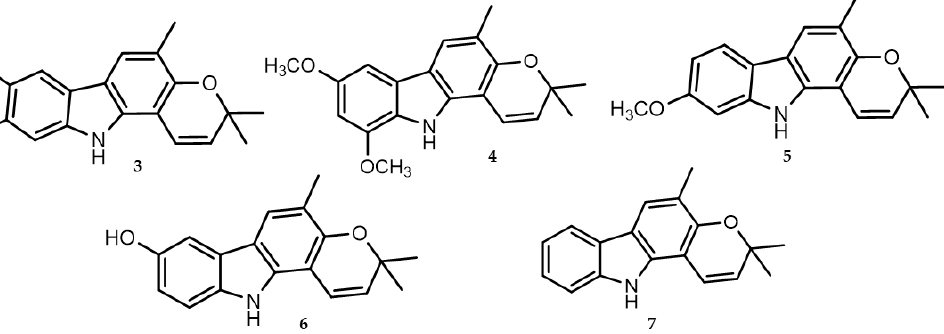
Figure 3. Structures of: koenigicine ( 3 ), mukonicine ( 4 ), O-methylmurrayamine A ( 5 ), koenine ( 6 ) and girinimbine ( 7 ) .